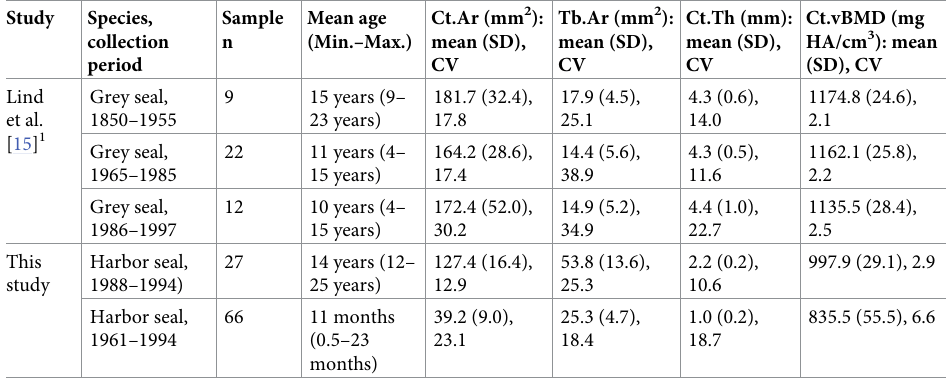
Table 4. Comparison of bone microarchitecture and bone mineral density of mandibles from grey seals, Hali- choerus grypus , [15] and harbor seals, Phoca vitulina (this study). SD = standard deviation, CV = coefficient of vari- ation